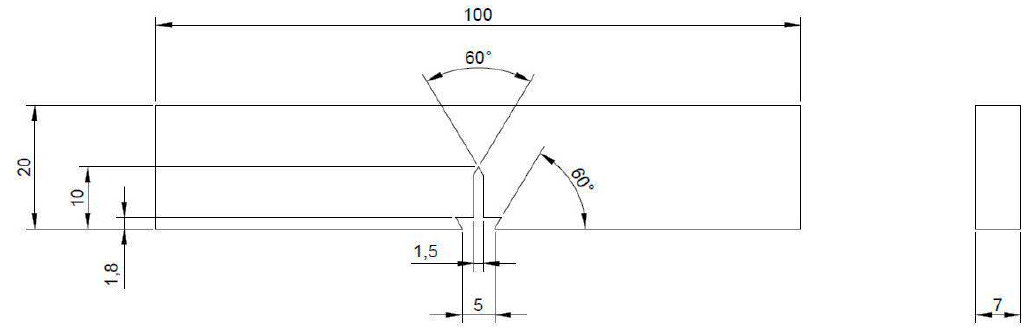
Figure 2. Typical specimen dimension and configuration for three-point bend test (all dimensions in mm).